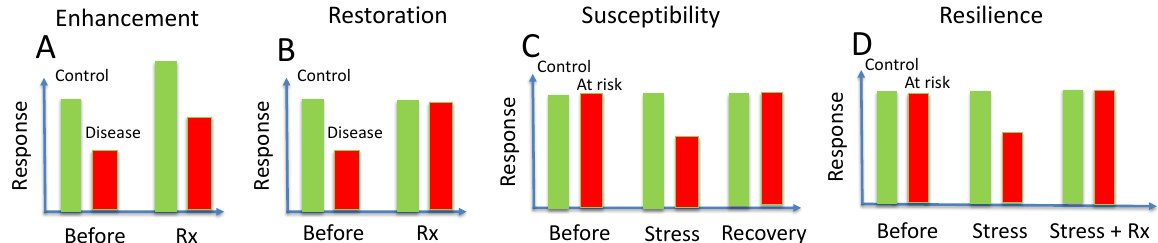
Figure 4. Conceptual examples of enhancement ( A ), restoration ( B ), susceptibility ( C ) and resilience ( D ) in control eyes (green bars) and diseased/at risk eyed (red bars).